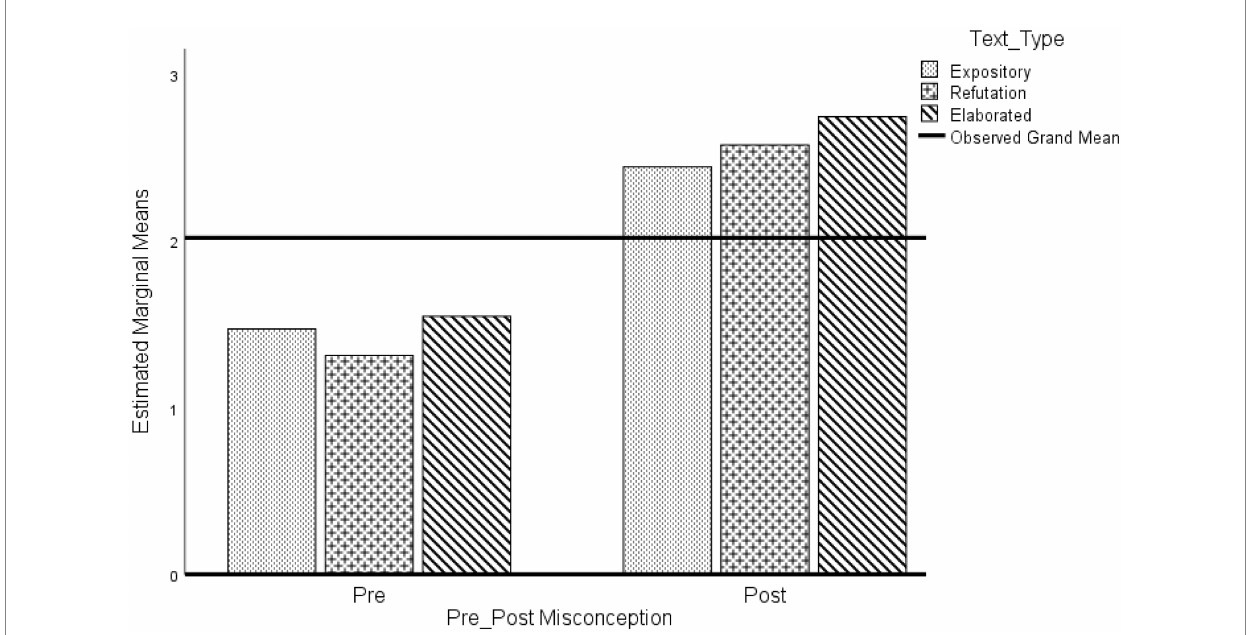
FIGURE 1 Participant score on the conceptual knowledge test across the three text